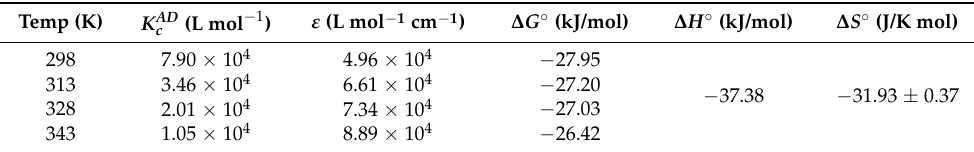
Figure 6. Benesi–Hildebrand plots at temperatures in the range of 25–70 °C. Table 8. Thermodynamic parameters for the determination of TIGC using CTC formation at various temperatures, λ CTC is 843 nm.